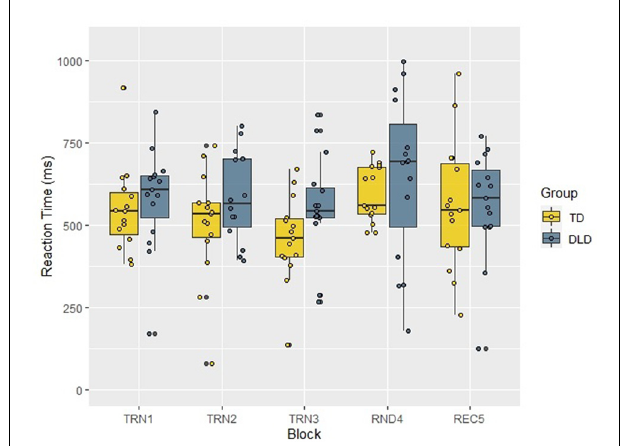
FIGURE 3 | Median RTs by Block and Group in the acoustic verbal target detection task. TD, typically developing children; DLD, children with Developmental language disorder; TRN1, First training block; TRN2, Second training block; TRN3, Third training block; RND4, Random block with disrupted structure; REC5, Recovery